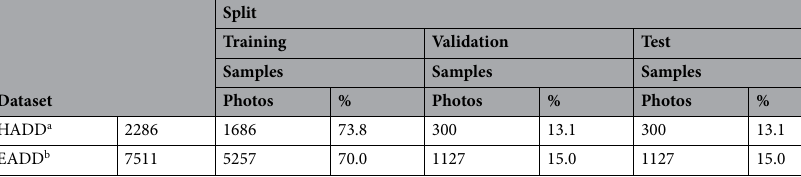
Table 1. Human-Annotated Detection Dataset (HADD), including human-labeled dorsal fin/saddle-patch bounding boxes, as well as Extended-Annotated Detection Dataset (EADD) containing human- and machine- labeled dorsal fin/saddle-patch bounding boxes. a HADD Human-Annotated Detection Dataset. b EADD Extended-Annotated Detection